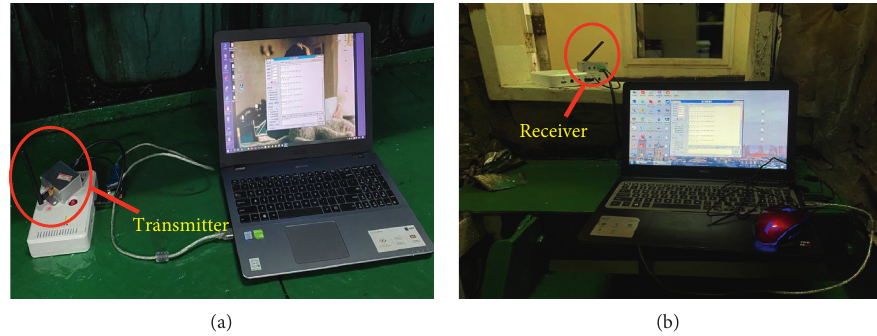
Figure 9: (a) The transmitter of the experimental system. (b) The receiver of the experimental system.